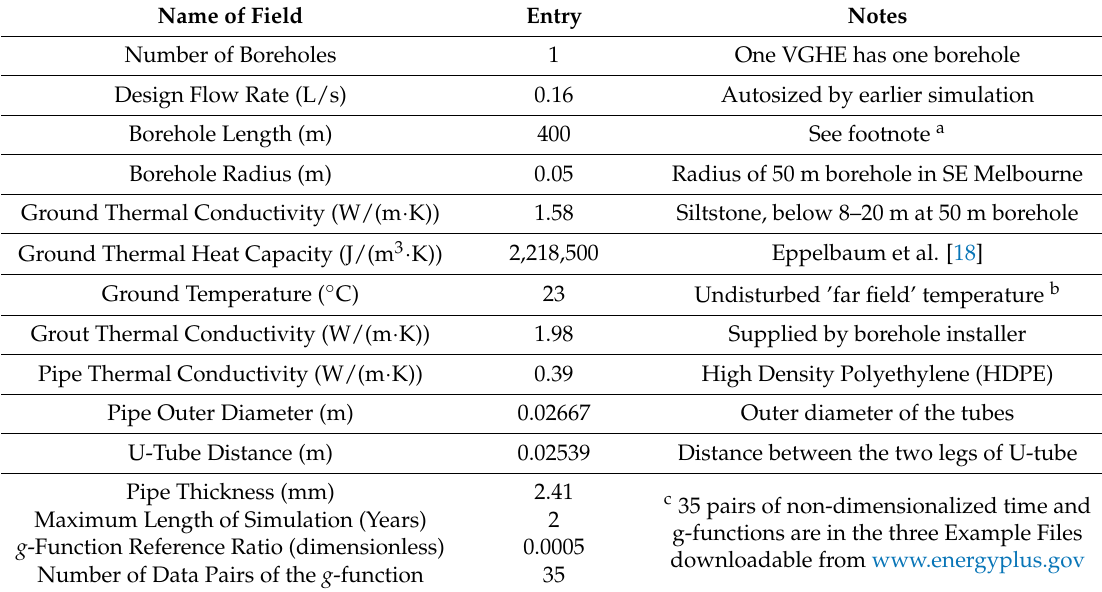
Table 3. Data for EnergyPlus’s GroundHeatExchanger:Vertical object that models the VGHE. Name of Field